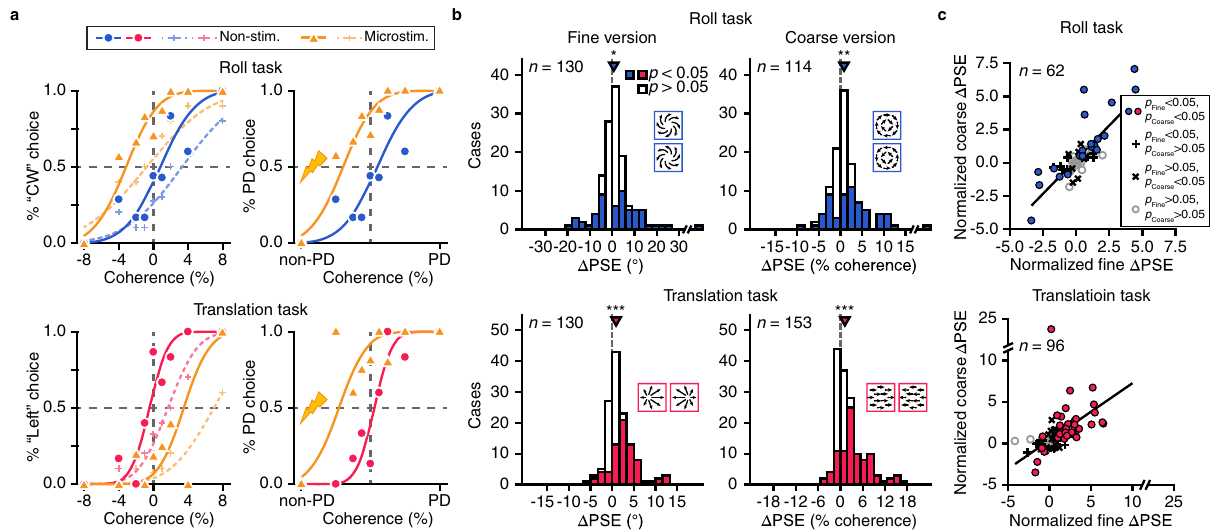
Fig. 4 | Microstimulation effect on PSE shift in 4-AFC roll and translation task. a Example psychometric function for non-stimulated trials (control trials, blue symbolsforrolltaskand red symbols fortranslationtask)andstimulated trials (orange symbols) from the same site as shown in Fig. 3a. Solid curves and fi lled dots, psychometric function including trials only with correct fl ow pattern choice.Dashedcurvesandcrosssymbols,generalerrorpsychometricfunction including all trials within each fl ow pattern. Left column: microstimulation effect as a function of the actual stimulus as in the behavioral performance (Fig. 2a). Right Column: microstimulation effect as a function of preferred direction (PD) of the stimulated site. b Summary of microstimulation-induced PSEshifts ( Δ PSE)in4-AFC taskfor fi ne and coarse versions.Positive Δ PSEvalue